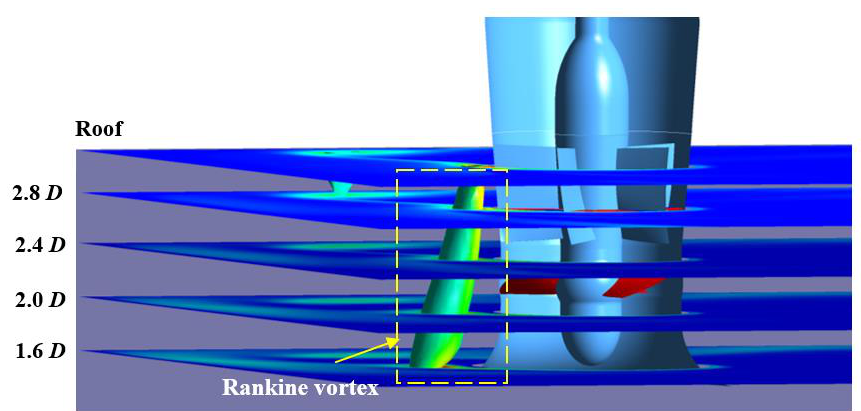
Figure 10. Rankine vortex in the closed sump.